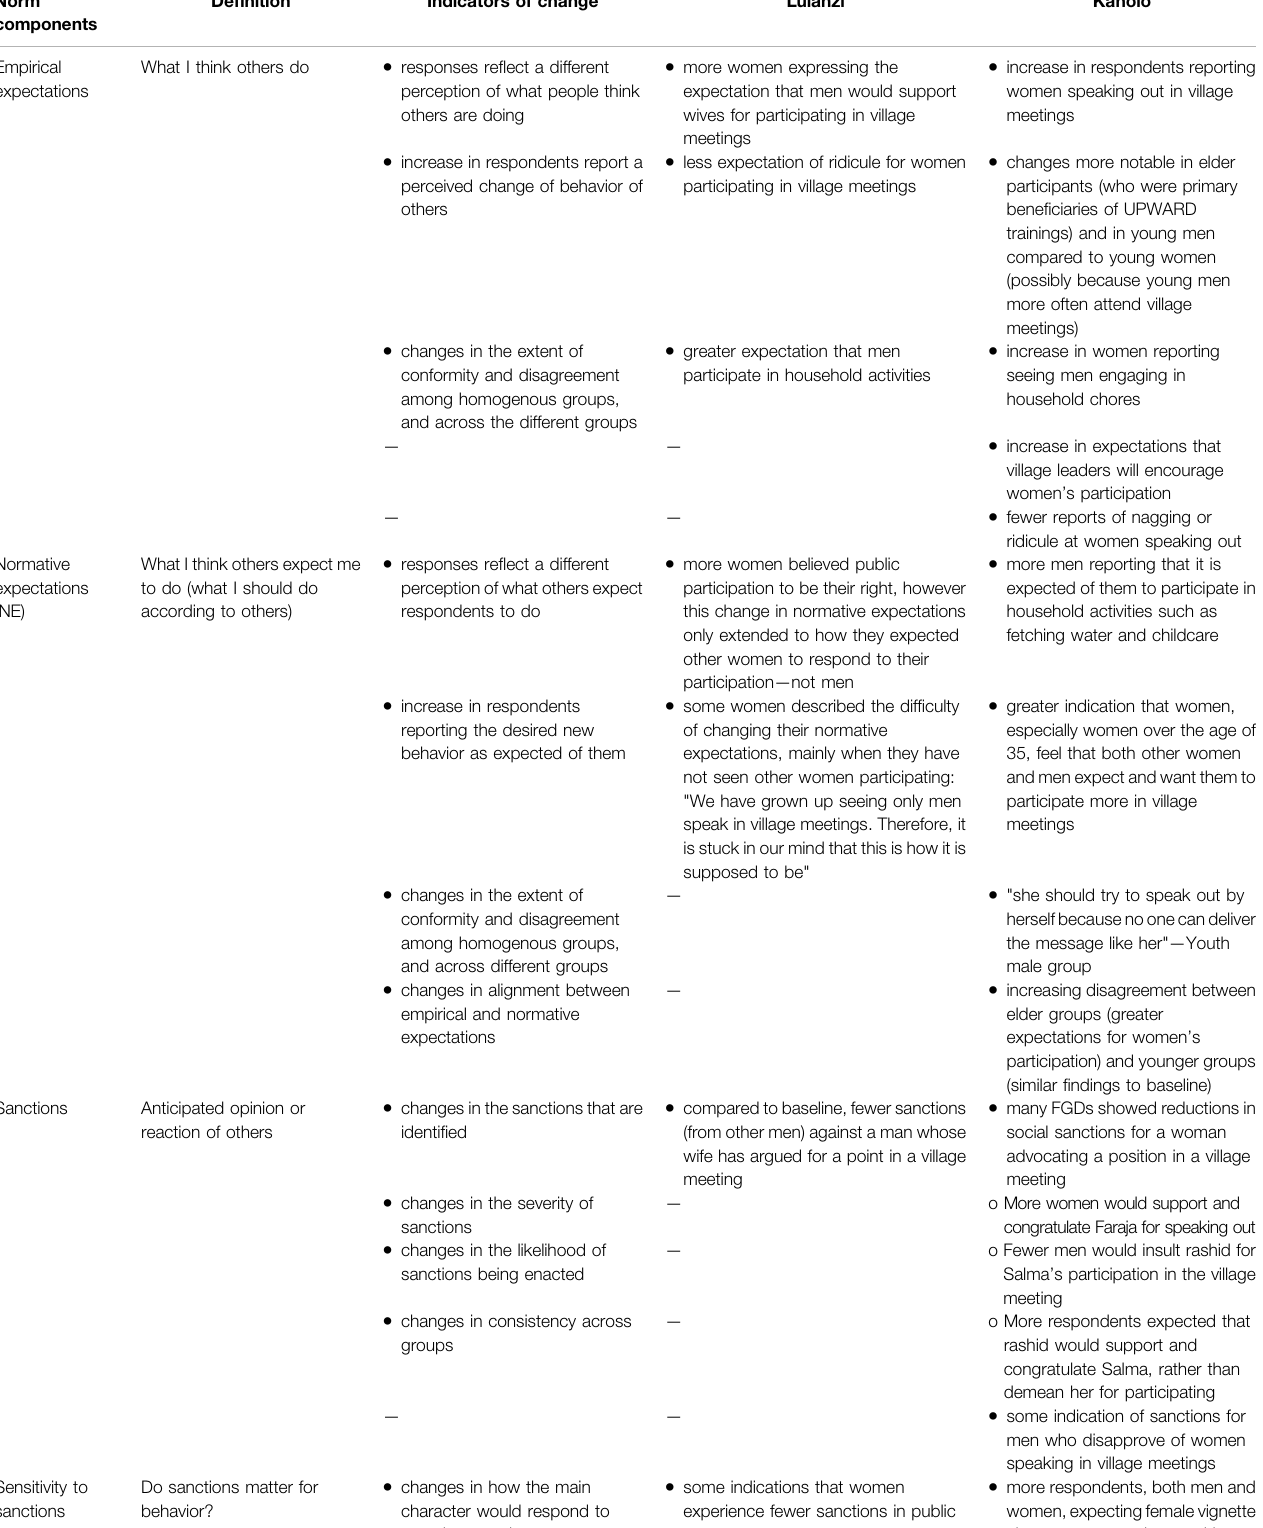
TABLE 3 | Social norms analysis plot. Norm components